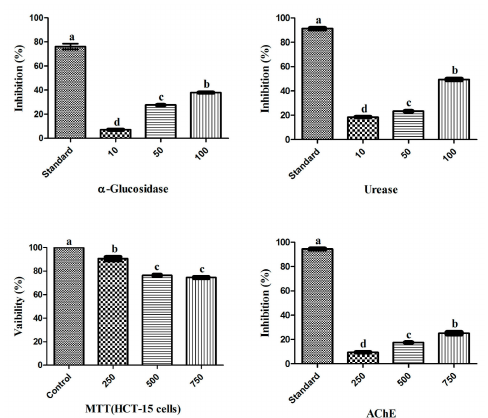
Figure 1. Biological potential of endophytic RWL-1 crude extract. The graph values are presented as the mean of three replicates with standard error. The acarbose, thiourea, DMSO and galantamine was used as reference standard for α -Glucosidase, Urease, MTT (HCT-15 cells) and AChE inhibition respectively. Bars with different letters are significantly different at p ≤ 0.05 based on Duncan multiple range